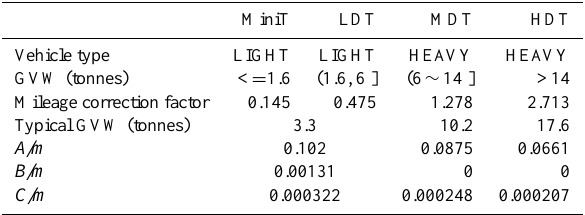
Table 2. Summary of road-load coefficient values for calculating VSP of each truck